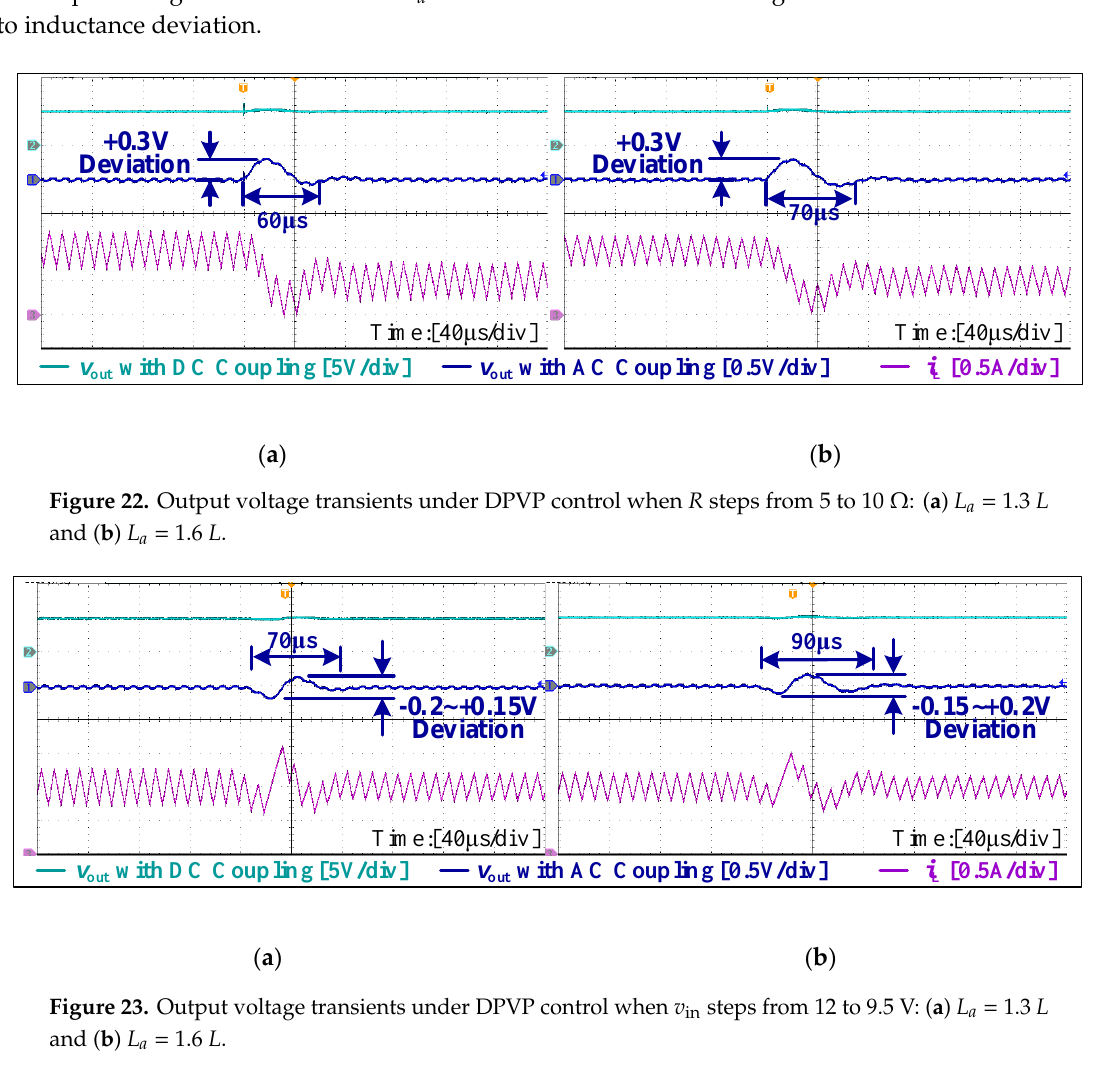
( b ) Figure 24. Output voltage transients under DPVP control when v REF steps from 5 to 6 V: ( a ) L a = 1.3 L and ( b ) L a = 1.6 L. All results match those of the analyses and simulations, and prove the effectiveness of the proposed DPVP control strategy. 6. Conclusions This paper proposes a State Switched Discrete-time Model and Digital Predictive Voltage Programmed controller for a buck converter operating in continuous conduction mode. Compared with the conventional state-averaged modeling method, the SSDM considers the variation of states within a switching cycle, and it achieves a higher accuracy at a medium and high frequency. Furthermore, based on SSDM, a DPVP control law is proposed that regulates the output voltage to its reference value in one switching cycle. Finally, with an integral compensation and saturation limit for DPWM, a practical DPVP control strategy exhibits a high stability and achieves very fast transient responses. The accuracy of SSDM has been proven by simulations, which were compared with the conventional state averaged discrete-time model and the circuit model. The stability and robustness under DPVP control was proven by open-loop and closed-loop frequency analyses. Finally, the effectiveness of the DPVP controller and the robustness to deviated inductance were verified through experiments. Author Contributions: Conceptualization and methodology, R.M.; project administration, Q.T.; resources, Q.Z.; software and validation, G.S.; supervision, Z.L.; writing—review and editing, W.W.